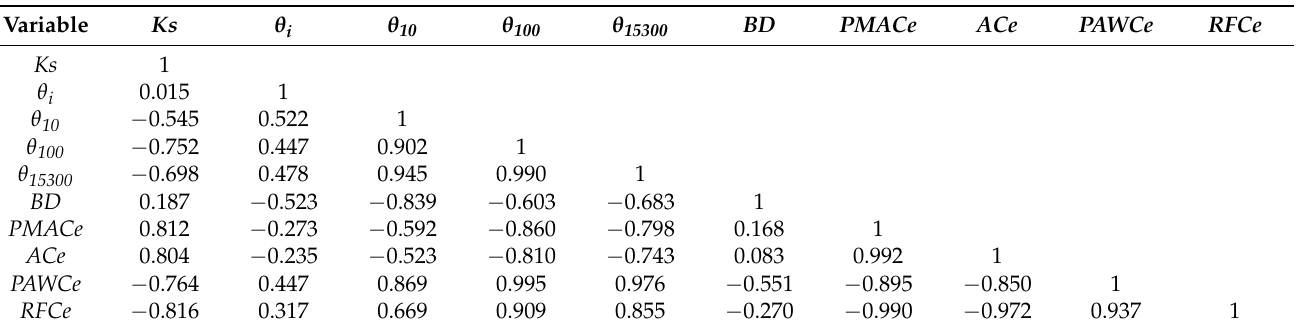
Table 2. Pearson’s correlation matrix for the variables under